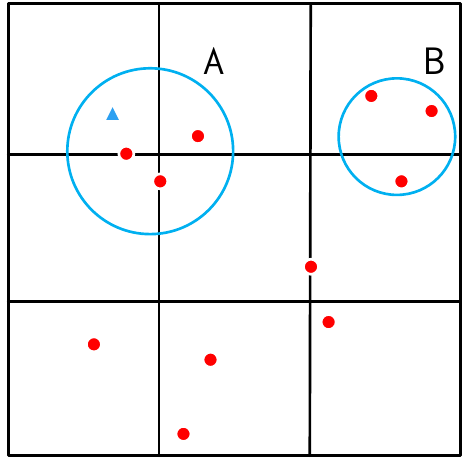
Figure 2. Location privacy protection based on k -anonymity.